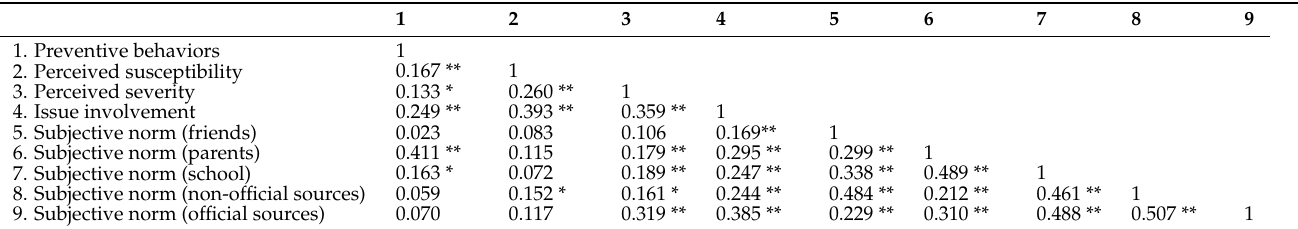
Table 3. Correlations between the study